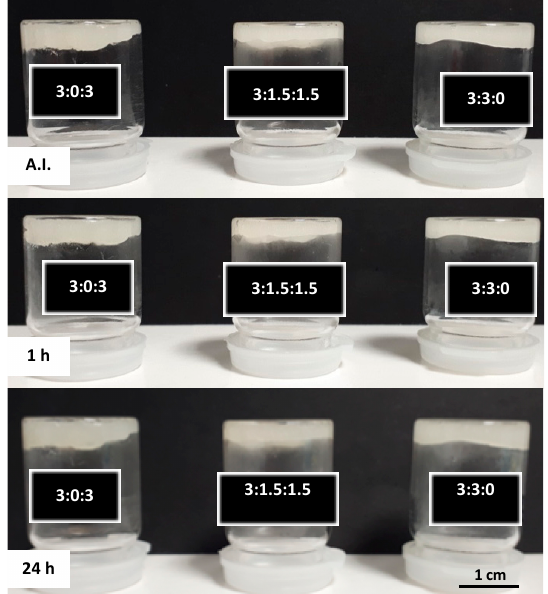
Figure 4. Observation of inverted vials containing hydrogels with different CHT:PCDi:PCDs ratios immediately after injection (AI) at room temperature (RT) and after 1 h and 24 h of incubation at 37 °C.